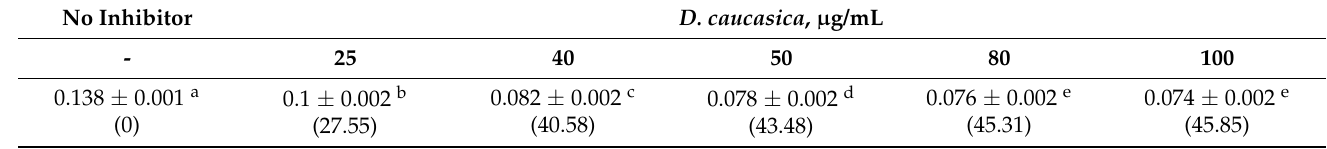
Table 4. The effect of D. caucasica 70% ethanol leaf extracts on specific activity of AChE (in µ M/min/mg protein) and percentage inhibition (in